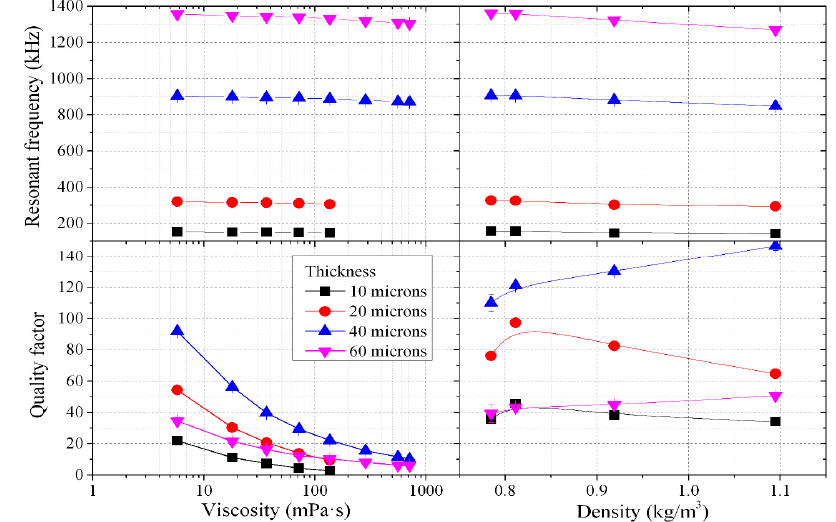
Figure 9. Resonant frequencies and quality factors for the second order roof tile-shaped mode (13-mode) in 1500 µm-long, 900 µm-wide cantilever devices of four different thicknesses in a wide range of liquid media. The left graphs show, as a function of the liquid viscosity, the experimental results in liquids with similar density (between 0.838 and 0.872 g/mL) while right graphs show, as a function of the liquid density, the results in liquids with similar viscosity (between 1.45 and 2.29 mPa·s).